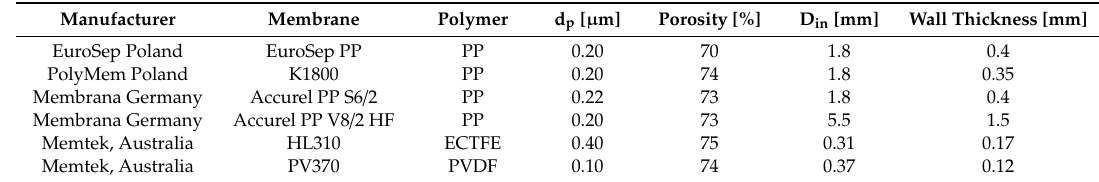
Table 1. Commercial capillary membranes assembled in submerged MD modules. Membrane parameters—manufacturers’ data.